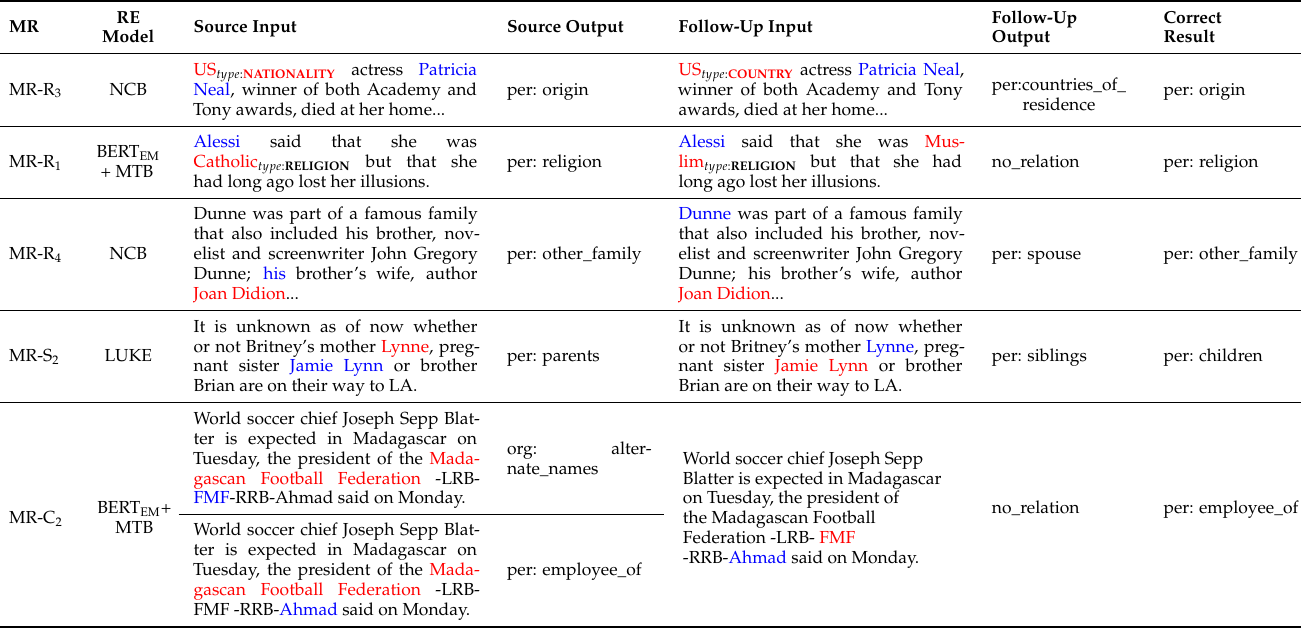
Table 7. Typical prediction failures of RE